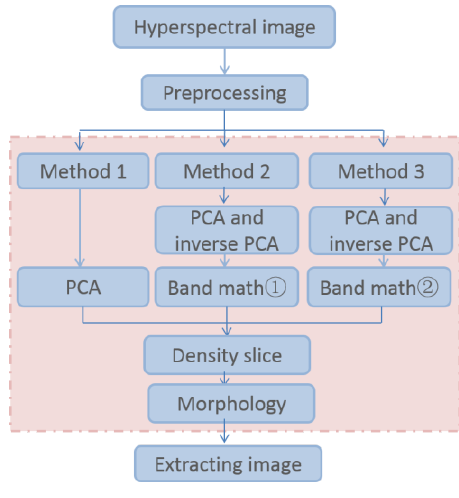
Figure1. Bottom of the ancient tomb picture